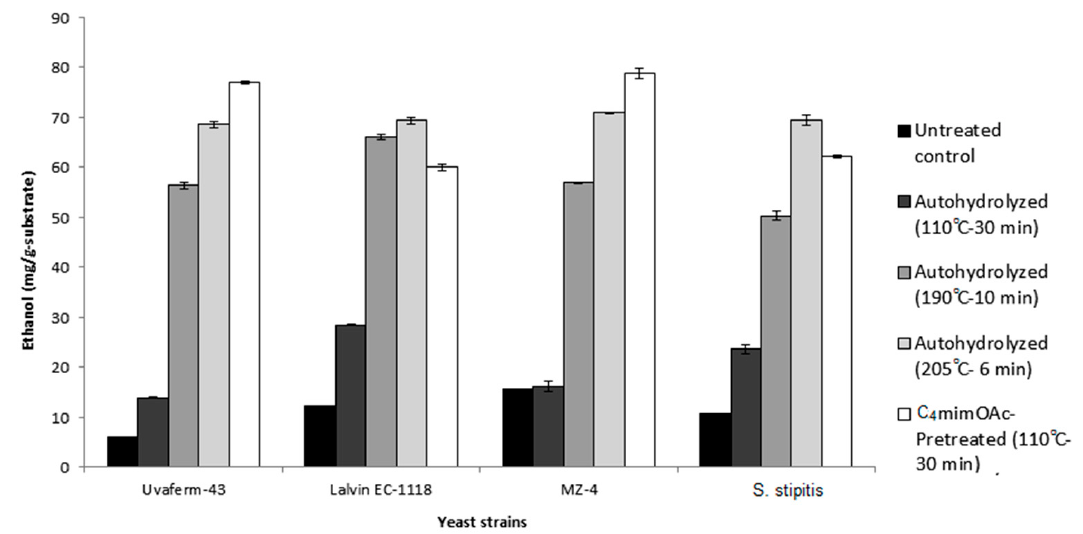
Figure 3. Ethanol content (mg/g-substrate) obtained after fermentation of autohydrolyzed and C 4 mimOAc-pretreated bagasse by using four different yeast strains.